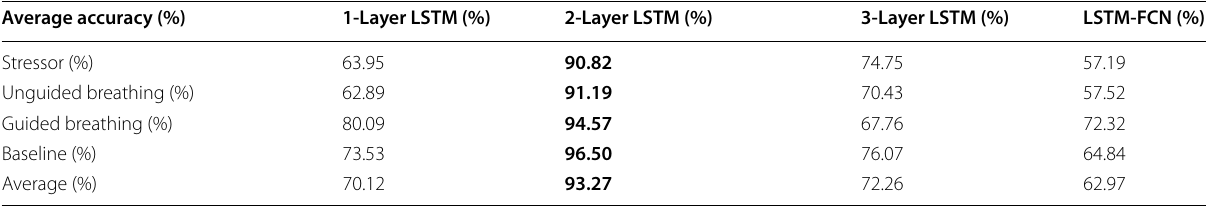
Highest classification accuracy are highlighted in